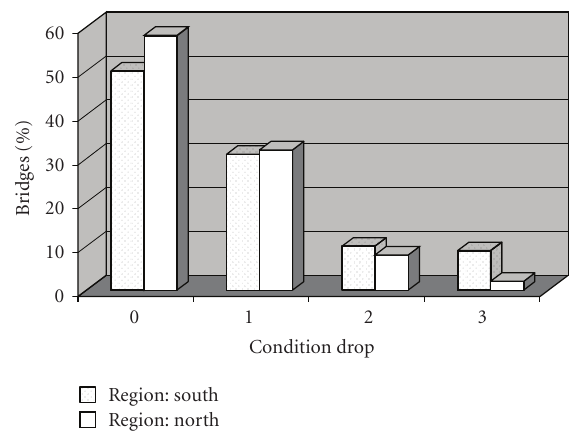
Figure 1: Trend of bridges deck condition deterioration in north/south region.